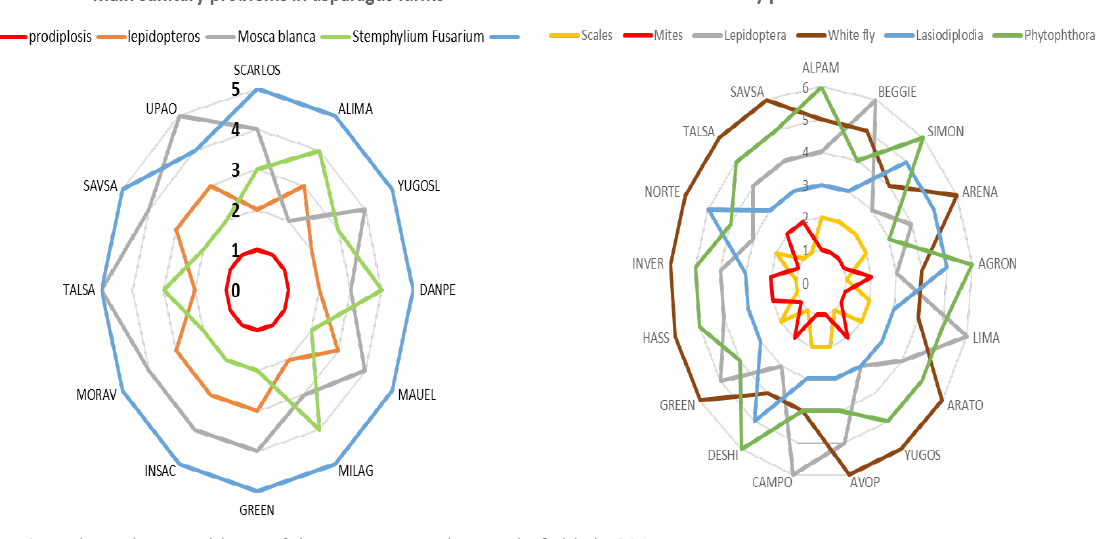
Figure 8. Main sanitary problems of the asparagus and avocado fields in 2017.